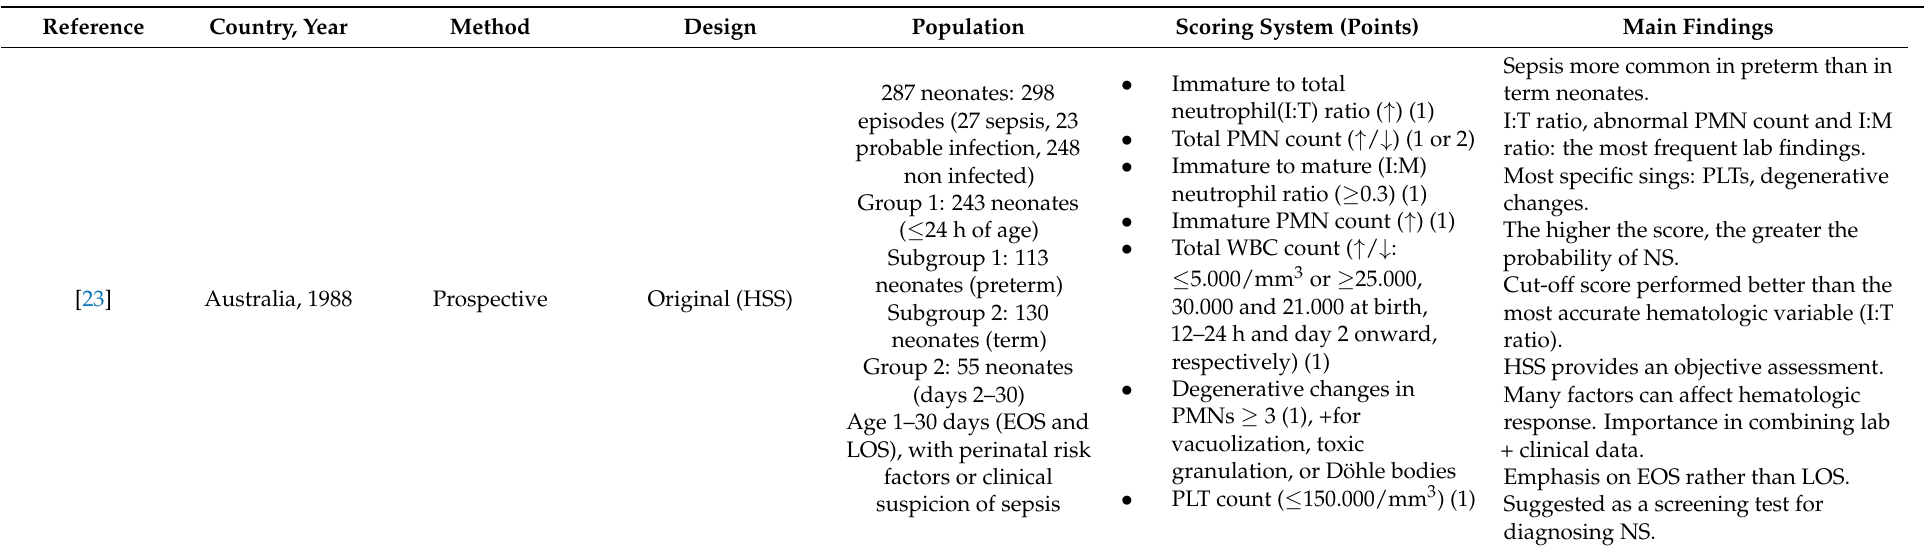
Table 2. Predictive scores for the LOS with laboratory